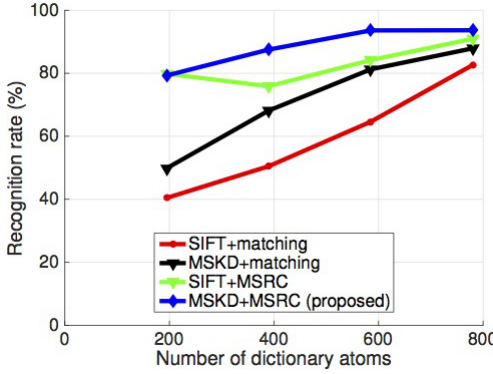
Figure 5. Recognition rate variation with the number of dictionary atoms on ISAR images database. Table 1. Comparison between the recognition rate (%) of different methods on ISAR images